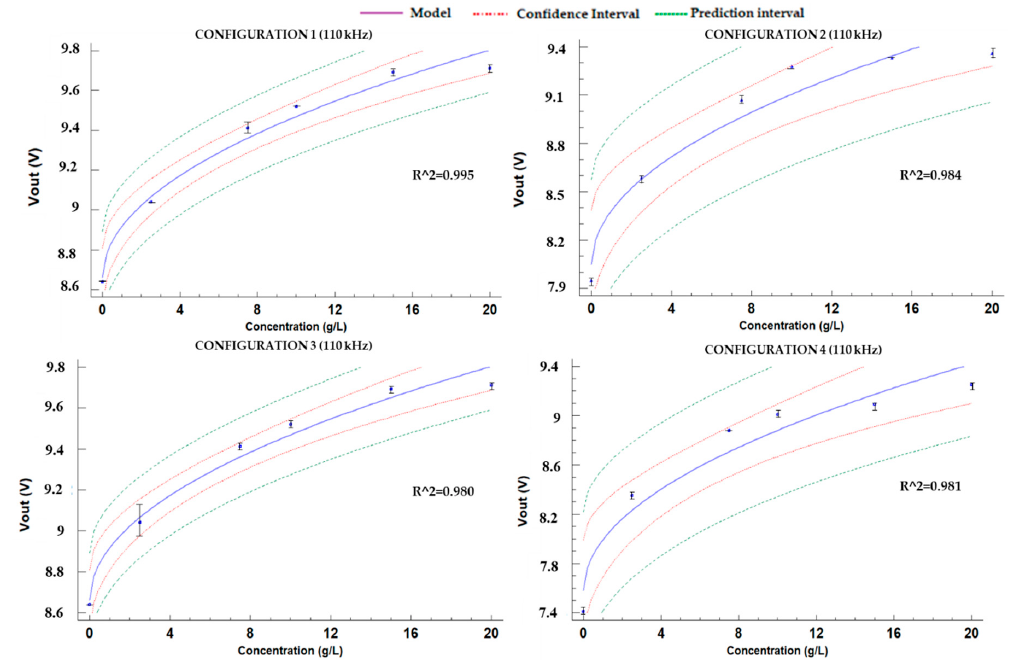
Figure 11. Adjusted models for the P2.